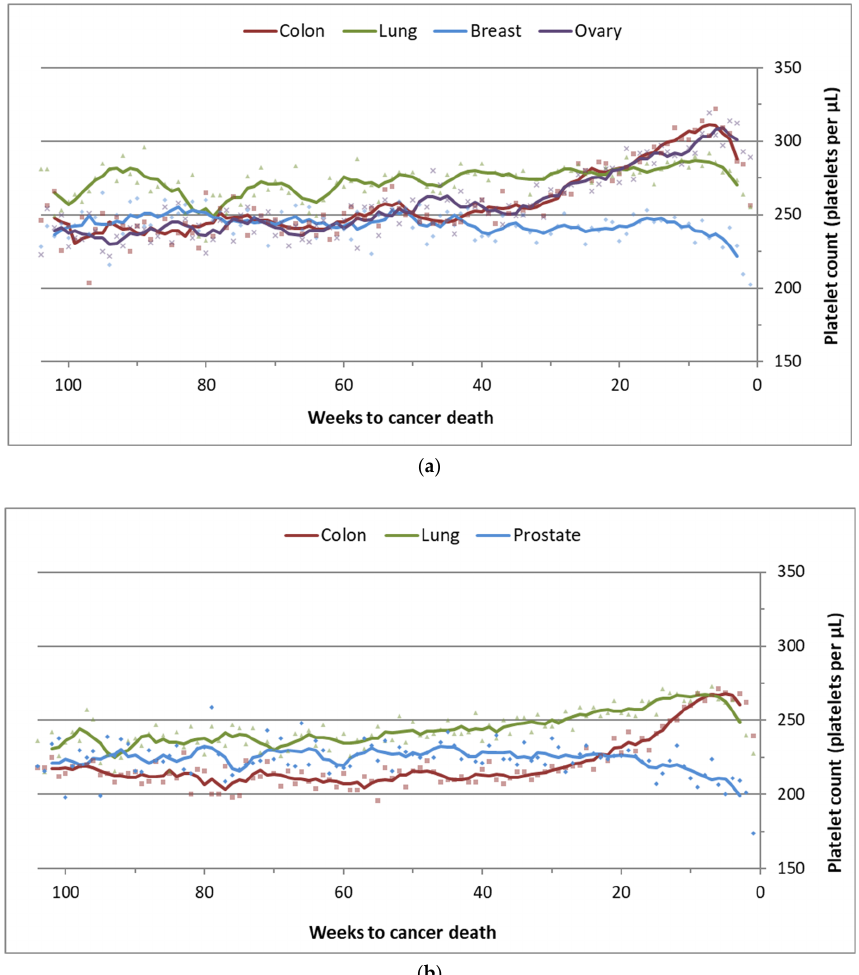
Figure 3. Median platelet count moving average (period of 5) in the 104 weeks (2 years) preceding death, among patients with a cancer-specific death. ( a ) Female patients; ( b ) male patients.